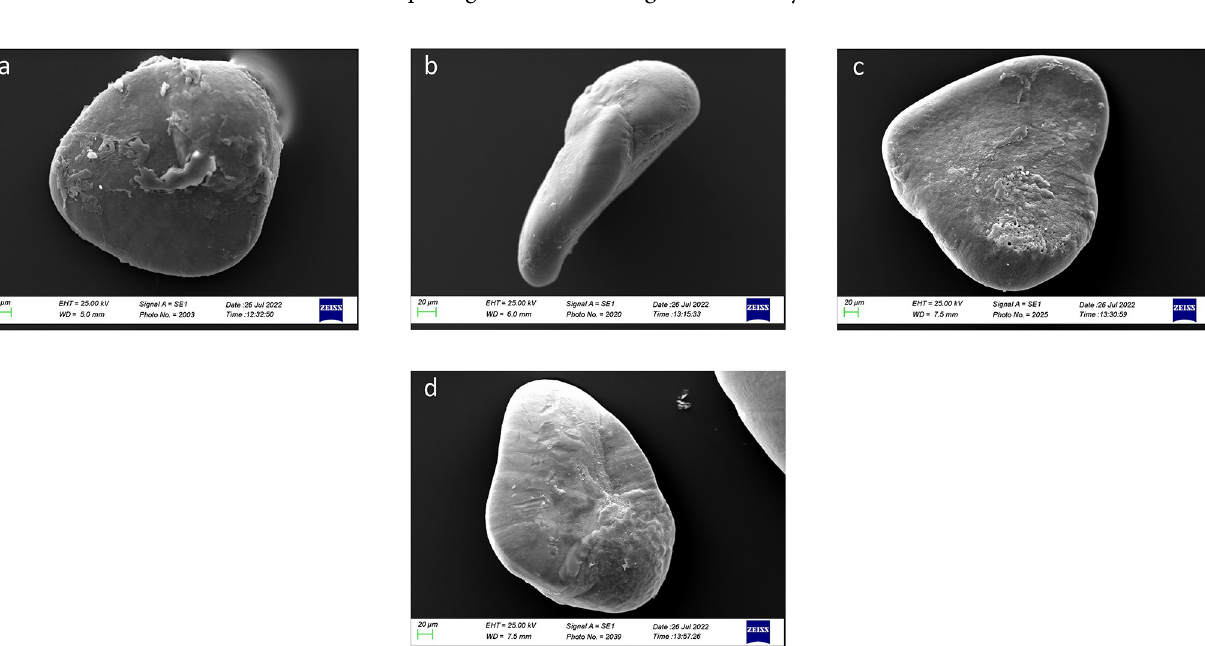
PLOS ONE | https://doi.org/10.1371/journal.pone.0281621 February 14,